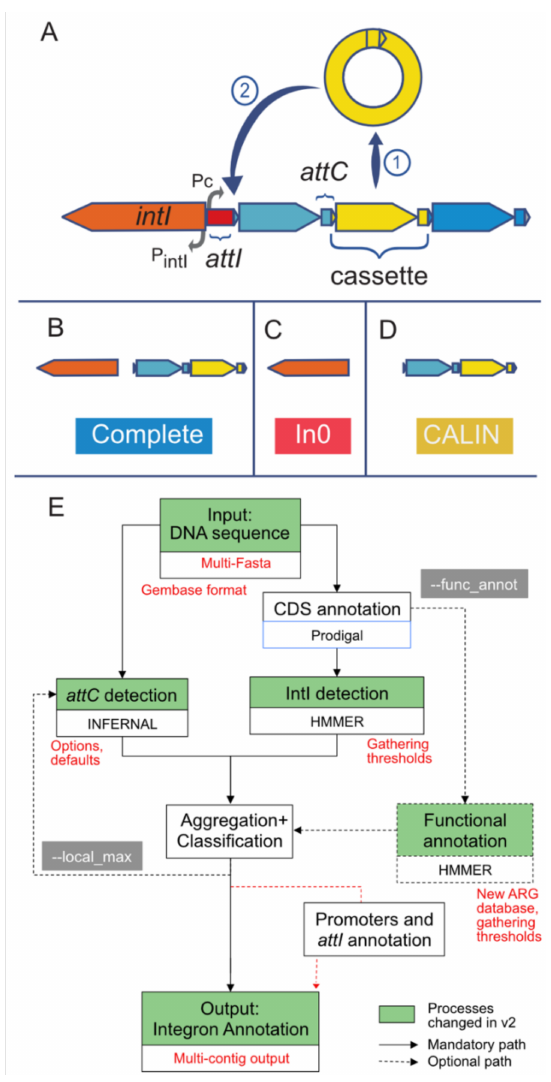
Figure 1. ( A ) Key genetic elements of integrons. ( B – D ) Different types of elements searched by IntegronFinder v2. ( E ) Diagram describing the different steps to identify and annotate integrons with in green the processes that were changed in some way (changes in red). Figure modified from